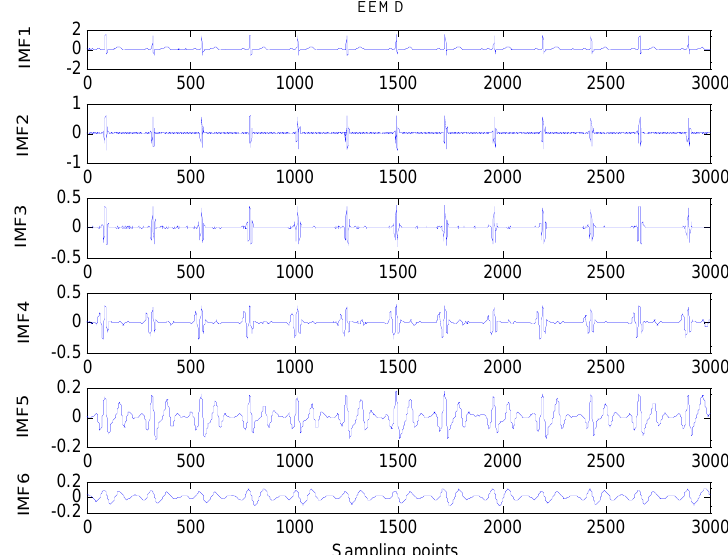
Figure 4. IMFs obtained by EEMD. From top to bottom is low level IMF to high level